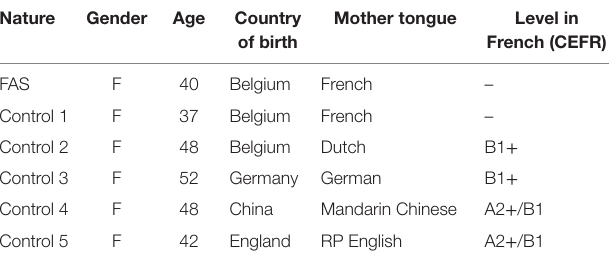
taBLe 5 | Demographic data of speakers (Fas and controls) in the perceptual accent rating experiment, including an indication of the level of French, CeFR, Common european Framework of Reference for Languages (Council of europe,